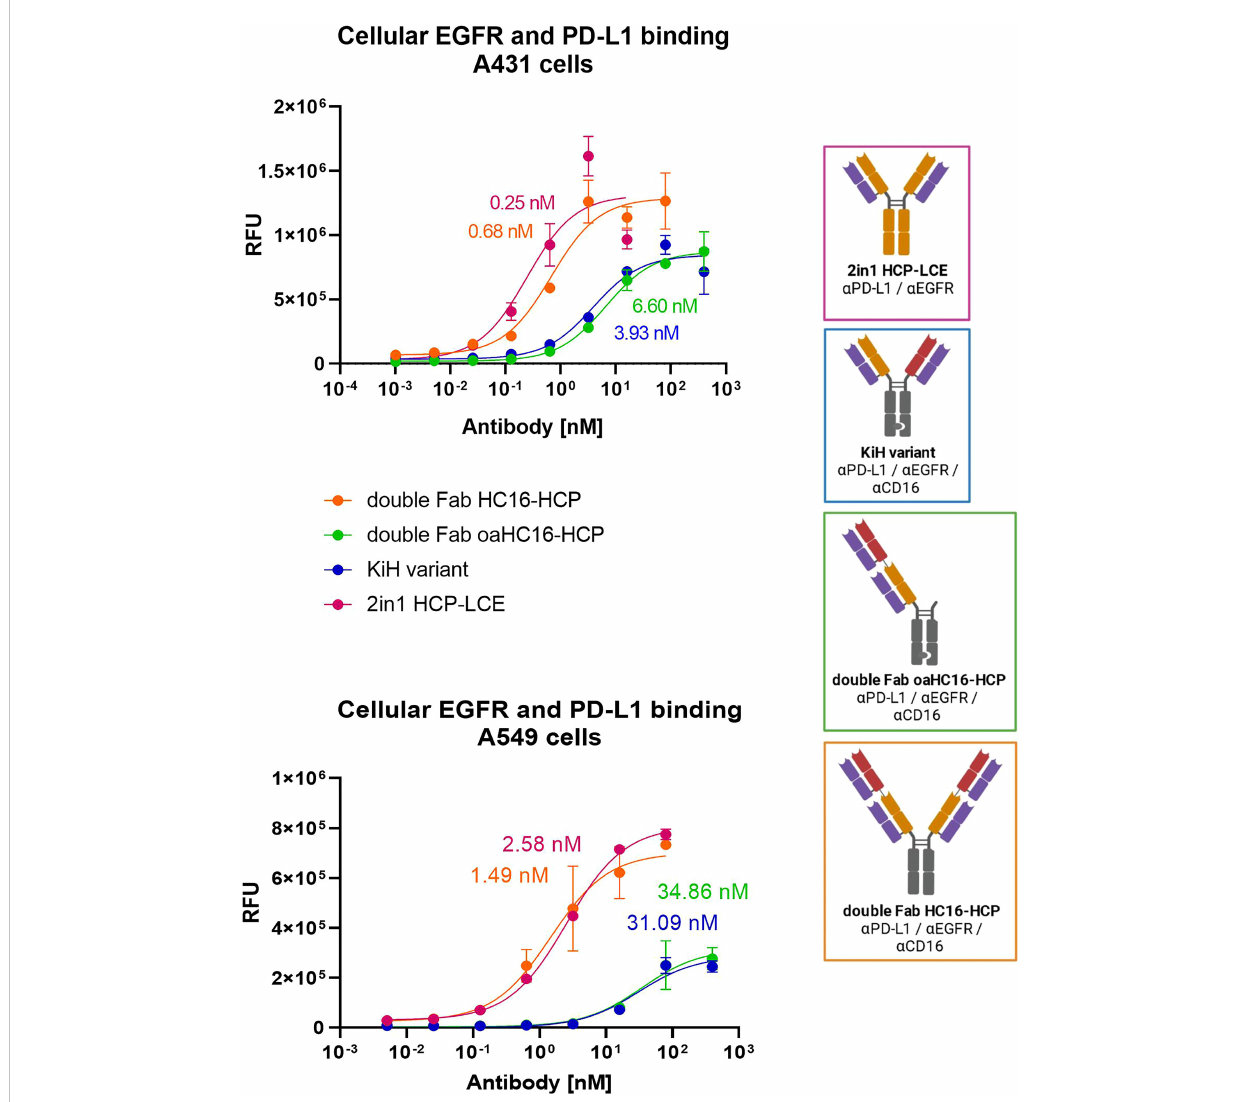
FIGURE 4 Cellular binding of trispeci fi c variants on EGFR and PD-L1 double positive cells. Cell titration of double Fab HC16-HCP (orange), double Fab oaHC16-HCP (green), KiH variant (blue) and HCP-LCE (pink) on EGFR/PD-L1 double positive A431 and A549 cells. A variable slope three-parameter fi t was used to fi t the resulting curves. EC50 values of A431 cellular binding: HCP-LCE, 0.25 nM; HC16-HCP, 0.68 nM; KiH, 3.93 nM; oaHC16-HCP, 6.60 nM. EC50 values of A549 cellular binding: HCP-LCE, 2.58 nM; HC16-HCP, 1.49 nM; KiH, 31.09 nM; oaHC16-HCP, 34.86 nM. All